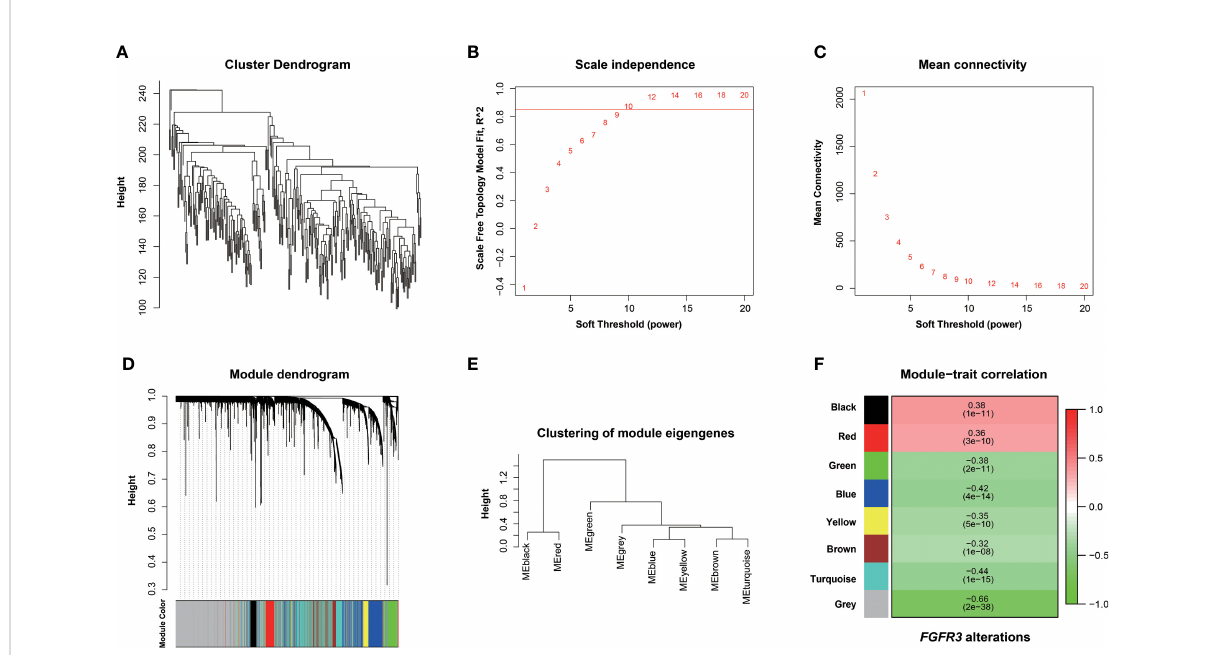
FIGURE 1 Screening FGFR3 alterations related to modules by the Weighted Gene Co-expression Network Analysis (WGCNA). (A) Hierarchical clustering based on mRNA expressions of 282 BC patients from TCGA. (B) Determination of power value in the WGCNA analysis. (C) The association between power value and connection degree. (D) Clustering and merging the co-expression modules. (E) Clustering of module eigengenes. (F) The heatmap of co-expression module- FGFR3 alteration correlation; red and green represent positive and negative correlation,